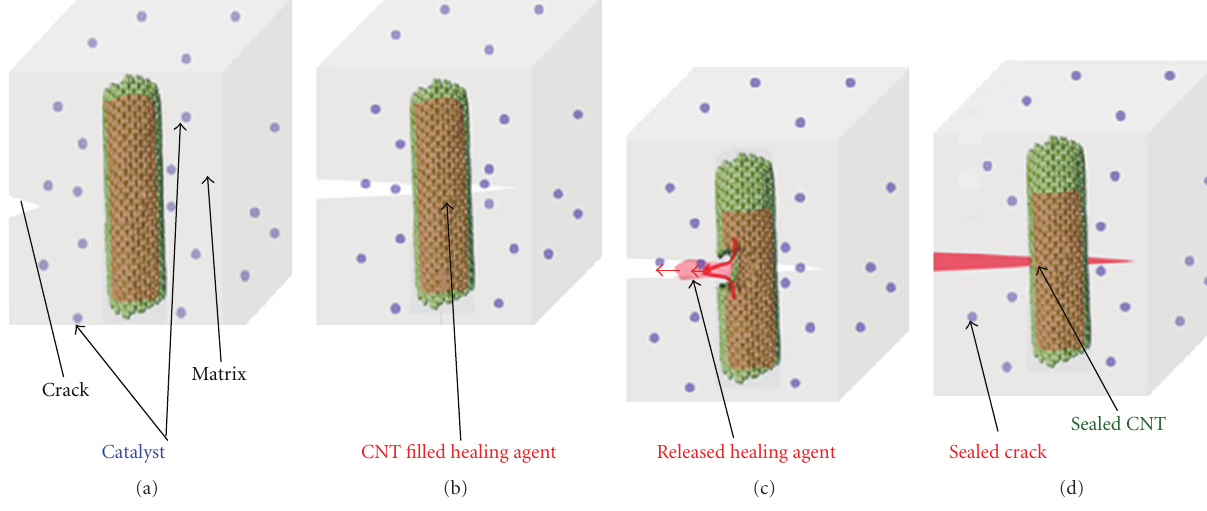
Figure 5: Concept of the self-healing process using carbon nanotubes. Adapted from